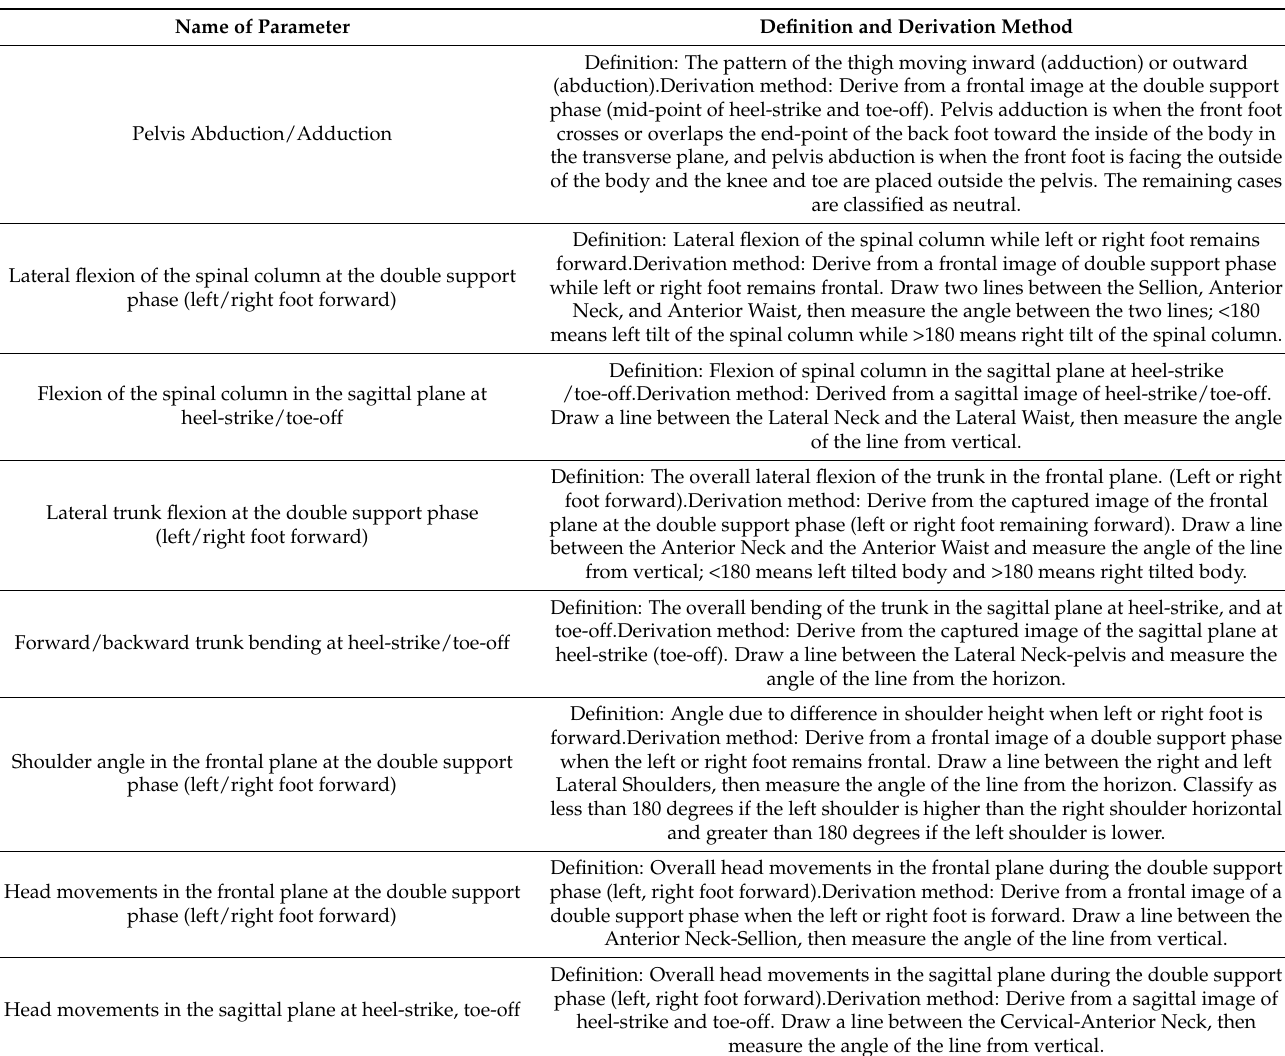
Table 3. Definition and derivation method of parameters of the upper